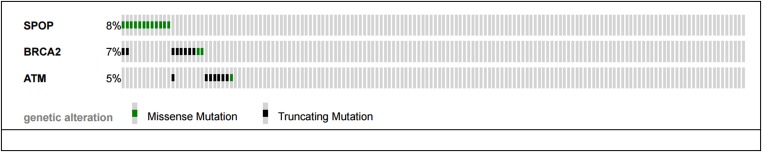
DOI:
http://dx.doi.org/10.7554/eLife.09207.028